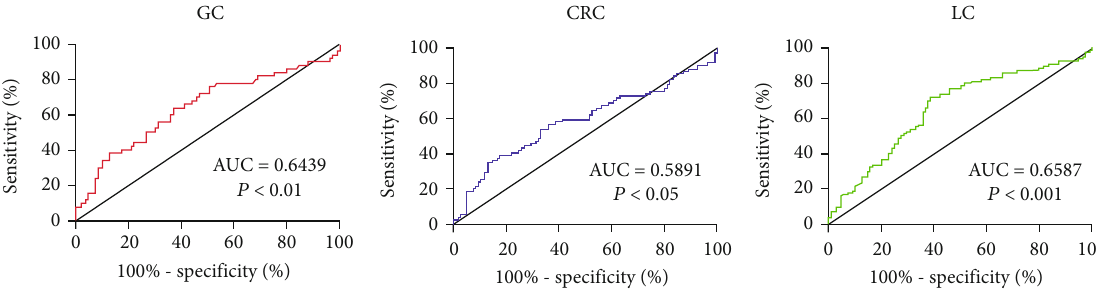
Figure 5: ROC curves of sB7-H5 in GC, CRC, and LC patients. The ROC curves were used to show the predictive ability.